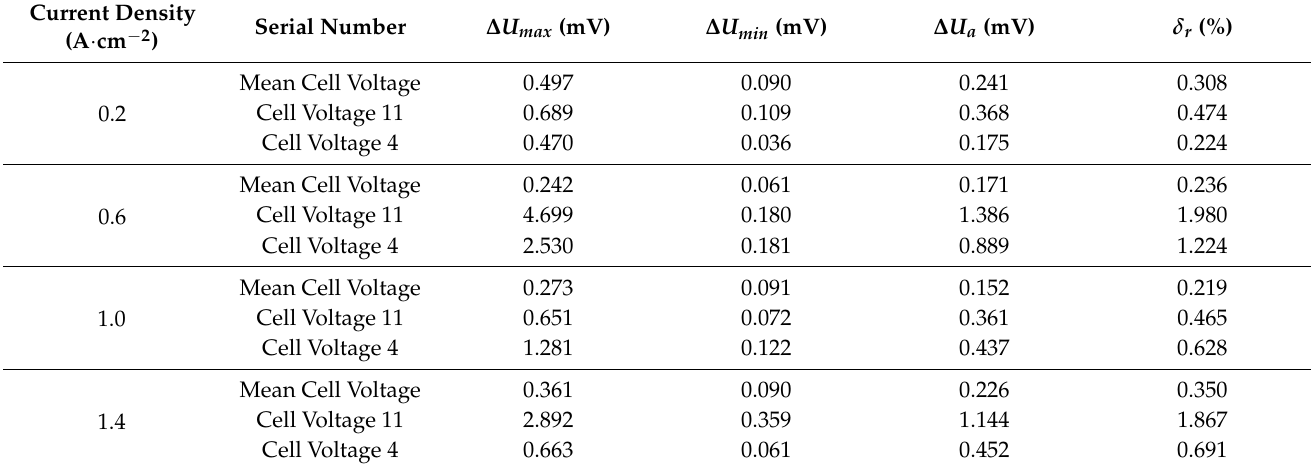
Table 2. Error analysis.